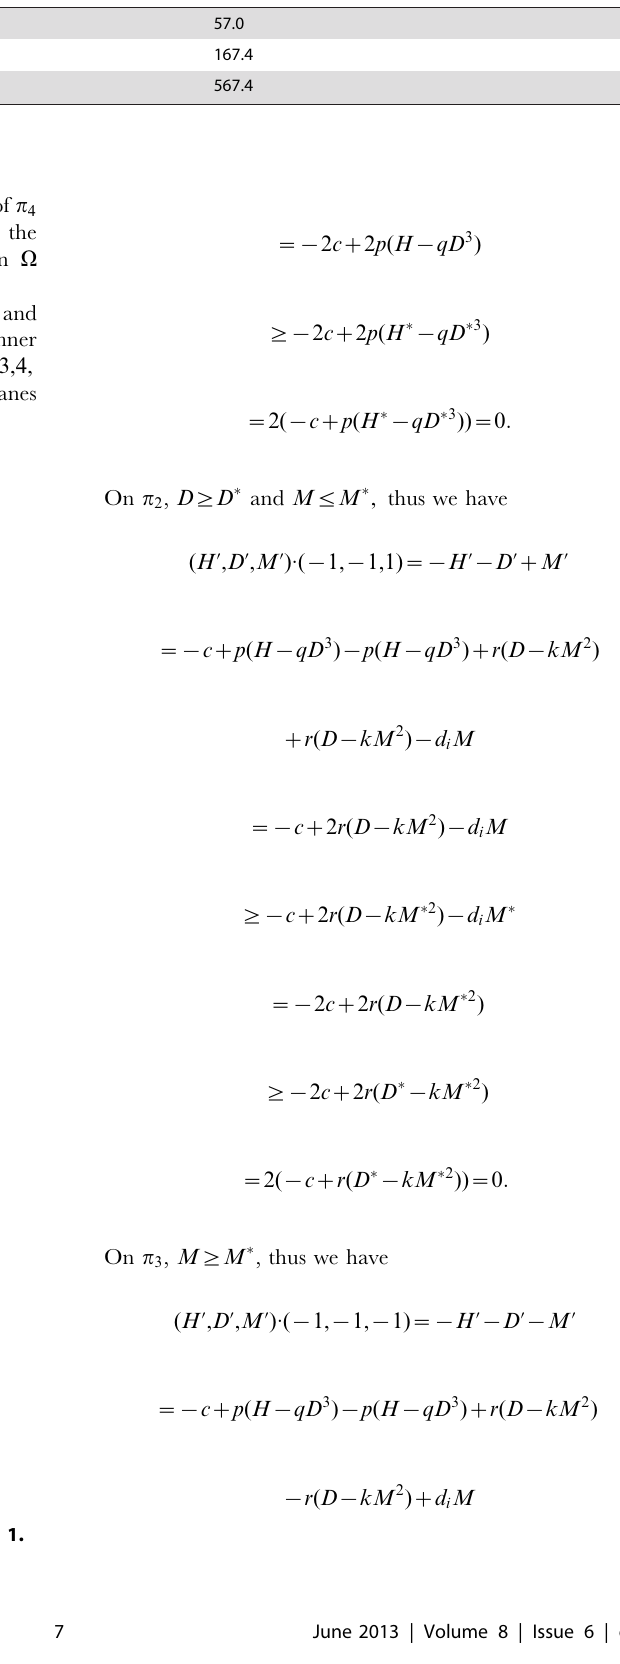
Glucose level (mM)